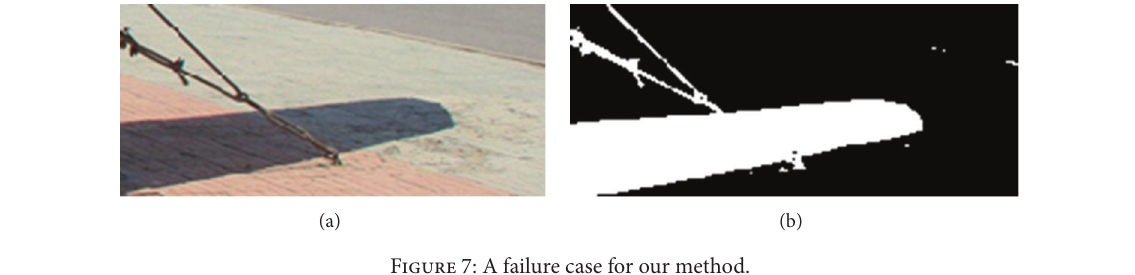
Figure 7: A failure case for our method.